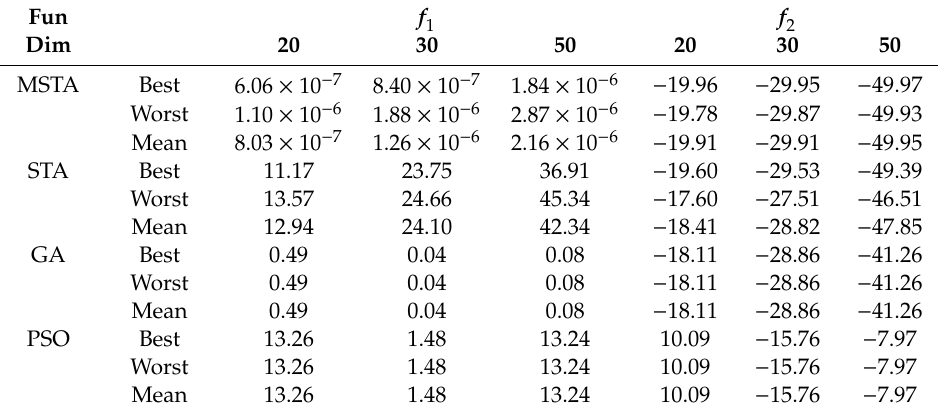
Table 2. Validation comparisons of di ff erent optimization algorithms.